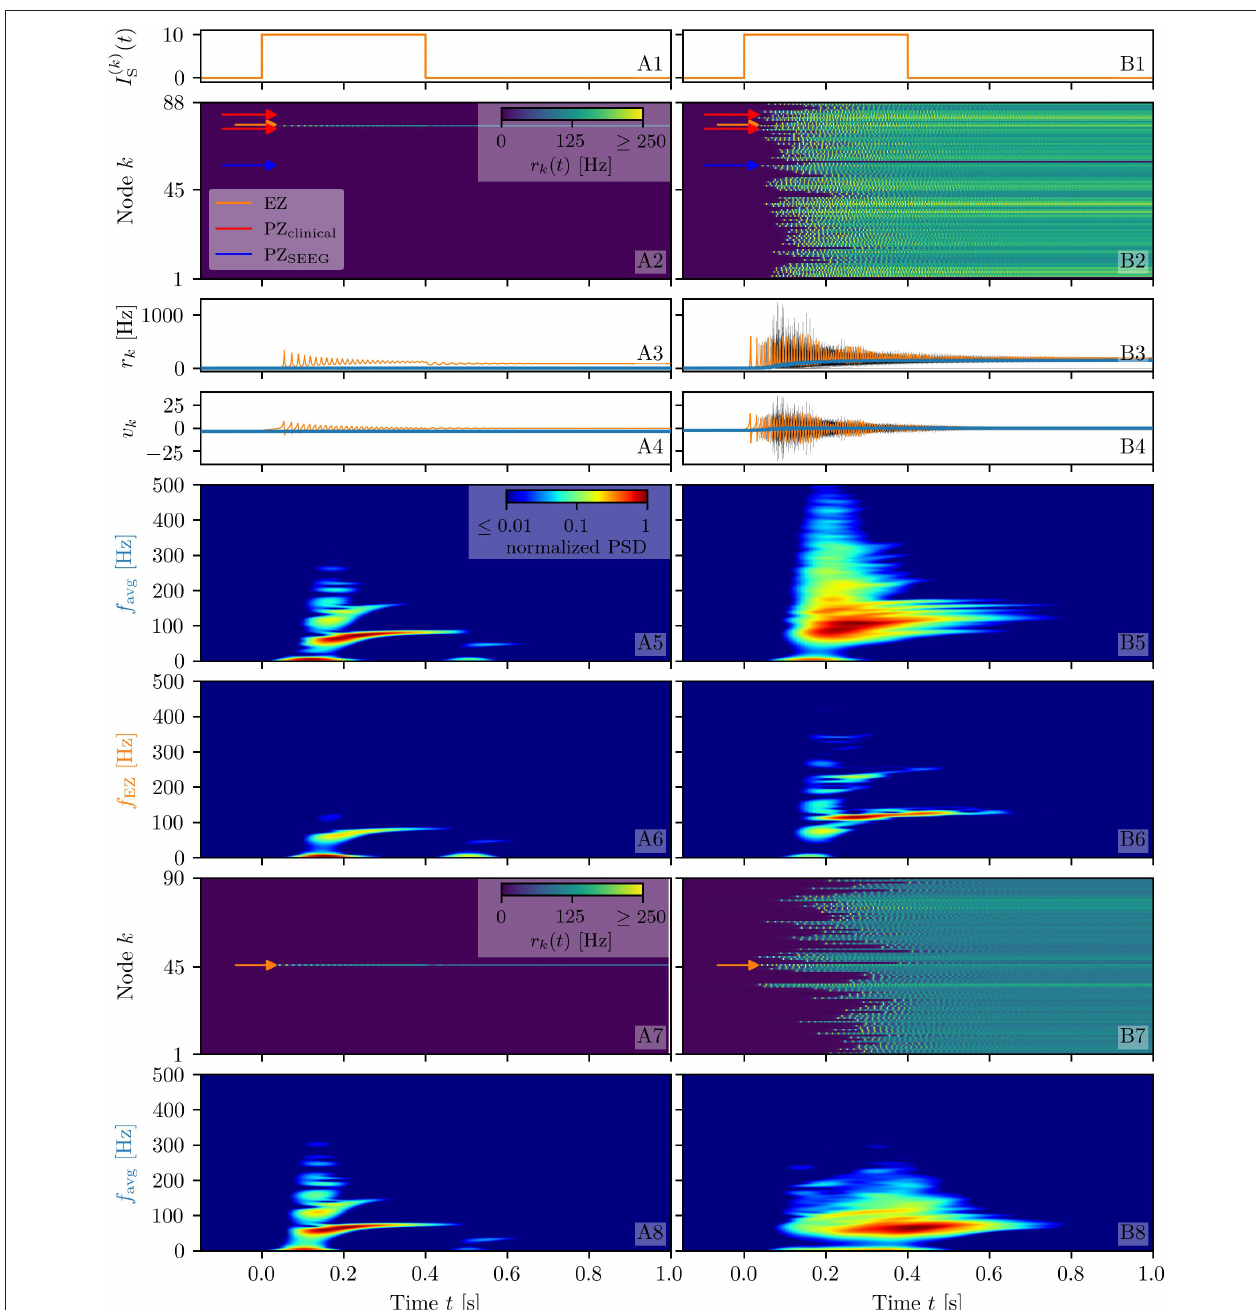
FIGURE 9 | Spectrograms of mean membrane potentials for patient E6. (A1, B1) Stimulation current I ( k ) S , (A3, B3) population firing rates r k , and (A4, B4) mean membrane potentials v k for the EZ (orange) and other populations (black). The blue curves show the network average firing rate and membrane potential. (A2, B2) Space-time plots of the population firing rates r k , color-coding the value of the firing rate of each node, as a function of time. (A5, B5) Spectrogram of the network average membrane potential and (A6, B6) of the v k of the EZ. Column A shows an asymptomatic seizure-like event for η seizure-like event for 7.5. The EZ node 77 (rh-PrG) is stimulated. Parameter values: N pop ¯ = − comparison are shown the space-time plots of the population firing rates r k (A7, B7) and the spectrogram of the network average membrane potential (A8, B8) for healthy subject H2. In accordance with the above panels, column A shows an asymptomatic seizure-like event (for η seizure-like event (for 5.3). The EZ node 46 is stimulated. Parameter values: N pop ¯ = −